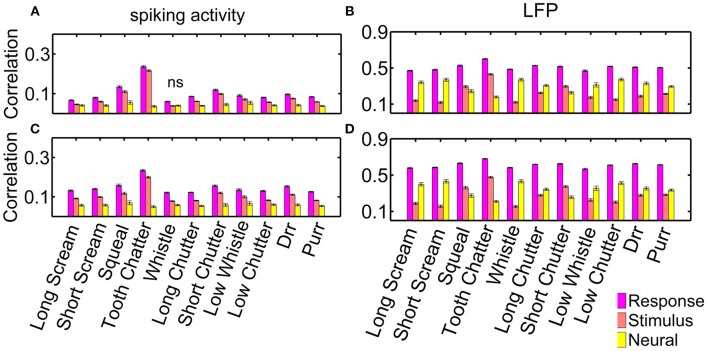
Response, stimulus-driven and neural correlations. Correlations for spiking activity, for (A) differently (n = 10,775 pairs); and (C) similarly frequency-tuned neurons (n = 4230 pairs); and correlations for LFP activity for (B) differently, and (D) similarly frequency-tuned neurons. Non-significant differences are denoted by ns, all other differences are significant (p = 0.05).